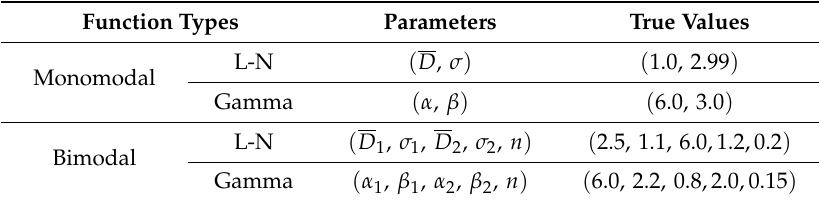
Table 1. The true values of characteristic parameters of ASDs.